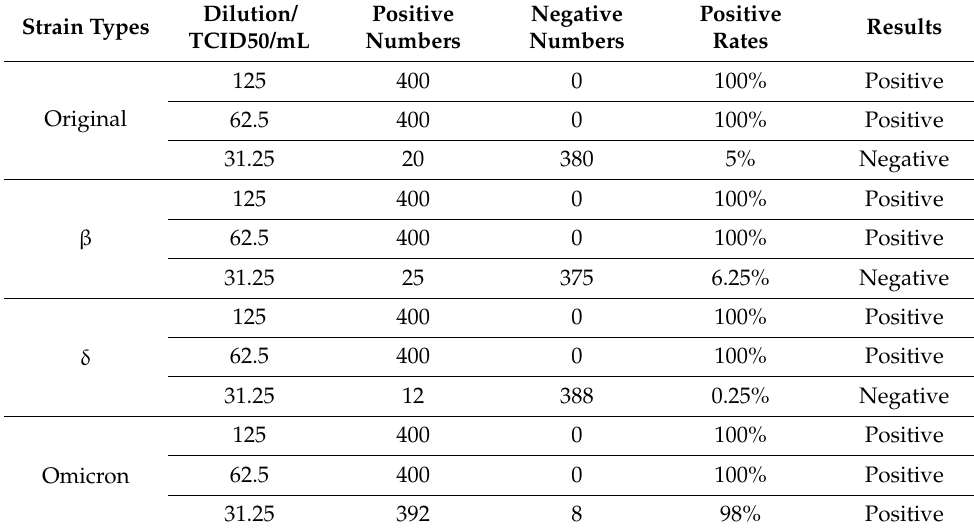
Table 7. The results of repeated dilution of SARS-CoV-2 culture samples.